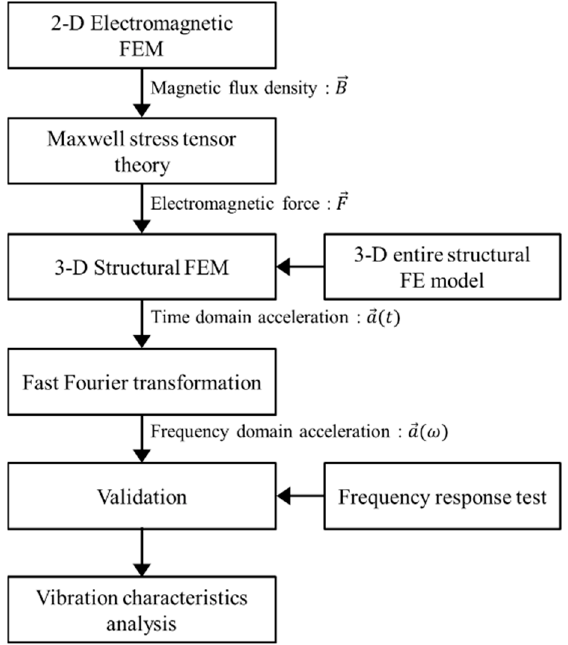
Figure 7. Electromagnetic-structural vibration coupled analysis process.